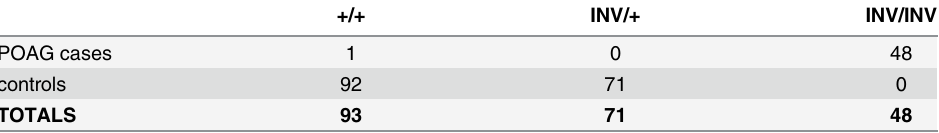
Table 1. Genotyping of an extended PBGV sample set for the POAG-associated inversion. +/+ INV/+ INV/INV POAG cases 1 0 48 controls 92 71 0 TOTALS 93 71 48 Results of genotyping 212 PBGV for the POAG associated inversion, where + represents the reference allele and INV represents the inversion